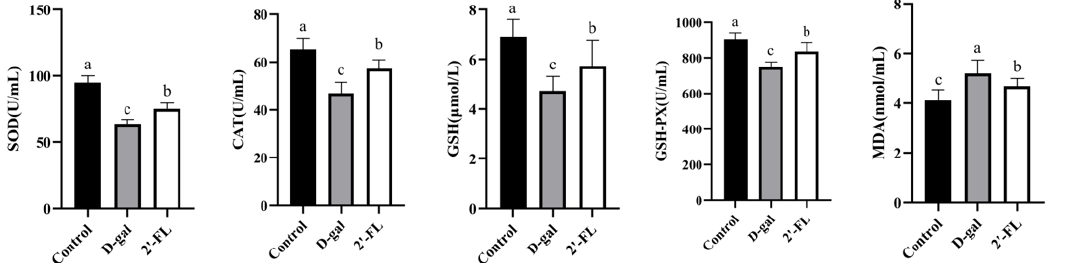
Figure 1. Effects of 2′− fucosyllactose ( 2′− FL) on oxidative stress. Letters a, b, and c indicated significant differences between groups ( p < 0.05).